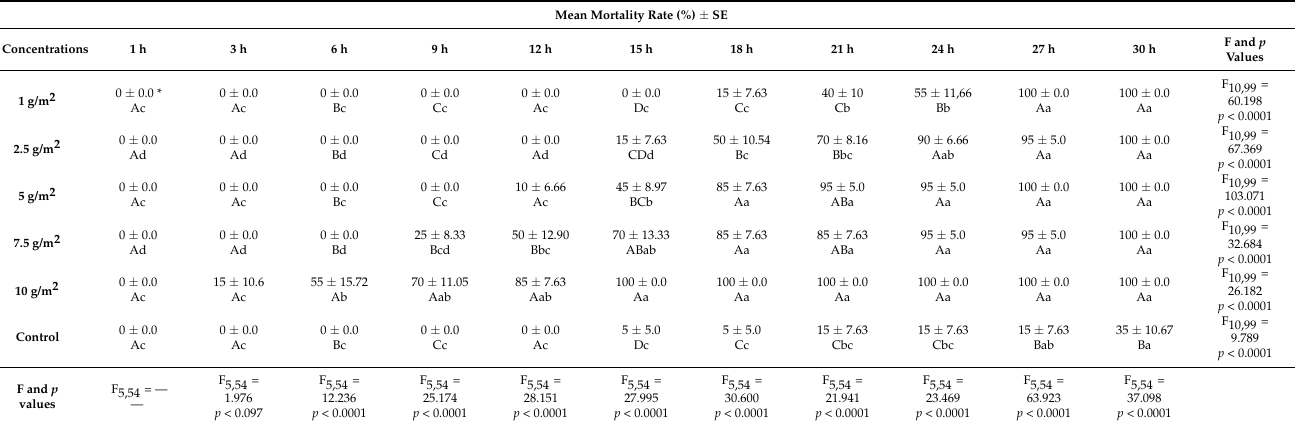
Table 2. Average mortality rate (mean + SE) of Tyrophagus putrescentiae exposed to five different concentrations of Detech ® WP 95 for certain time